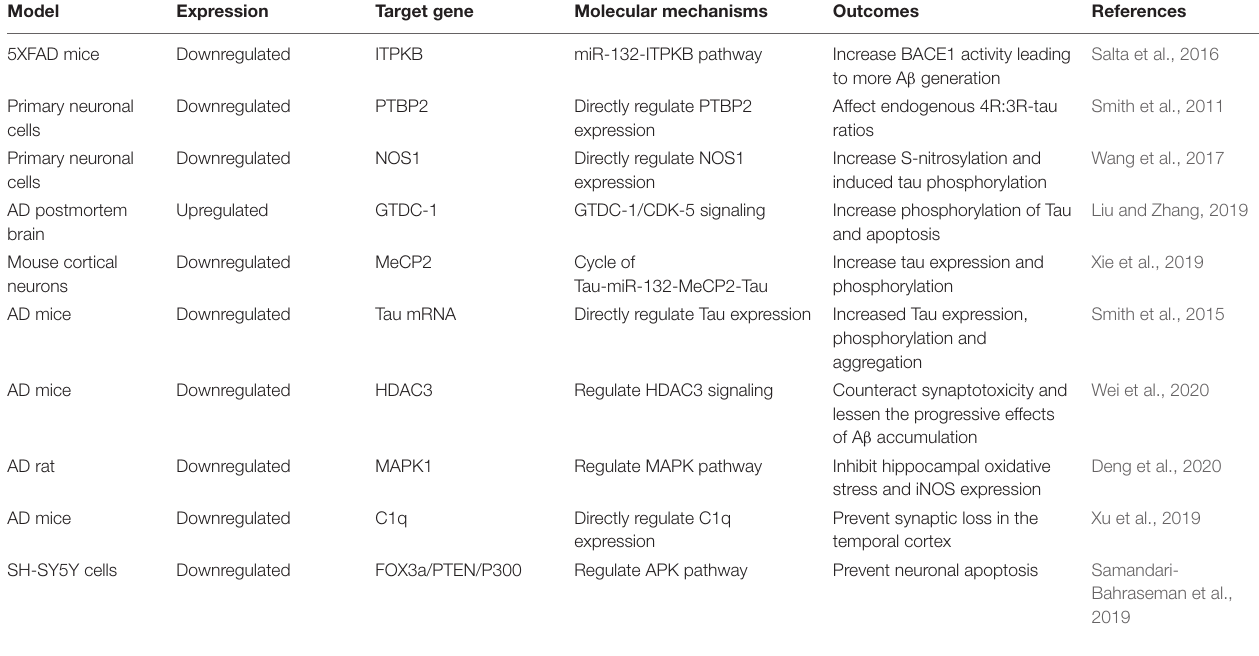
TABLE 1 | The role of miR-132 in Alzheimer’s disease: Evidence from in vitro and in vivo studies.